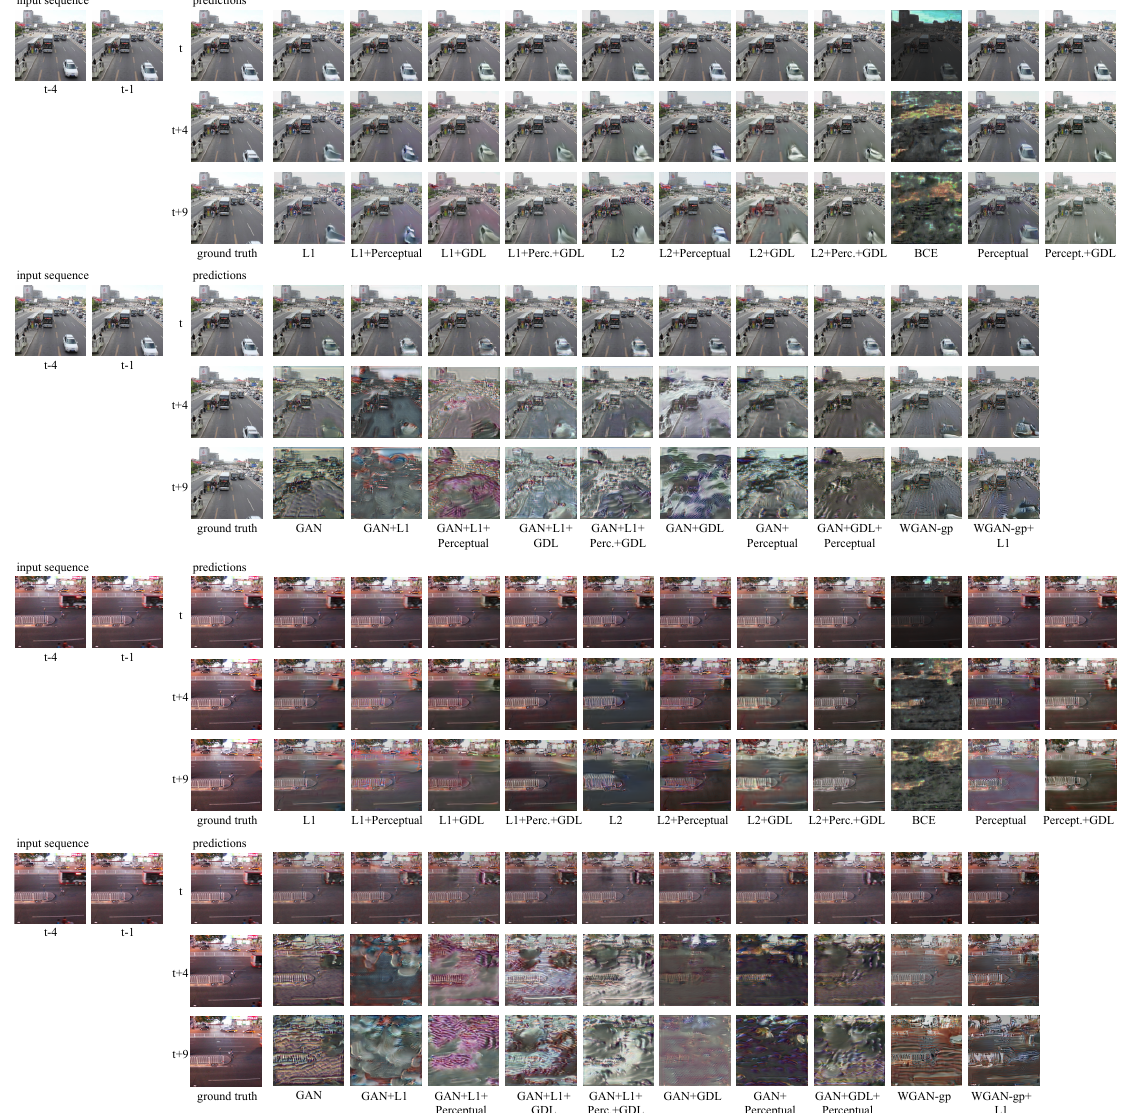
Figure A7. Qualitative results for the UA-DETRAC test split. To generate these images, we used the models that were trained on Cityscapes for 20 epochs. The models were trained to predict the next frame based on four past frames. All images are included in the supplementary material. (The images are best viewed on